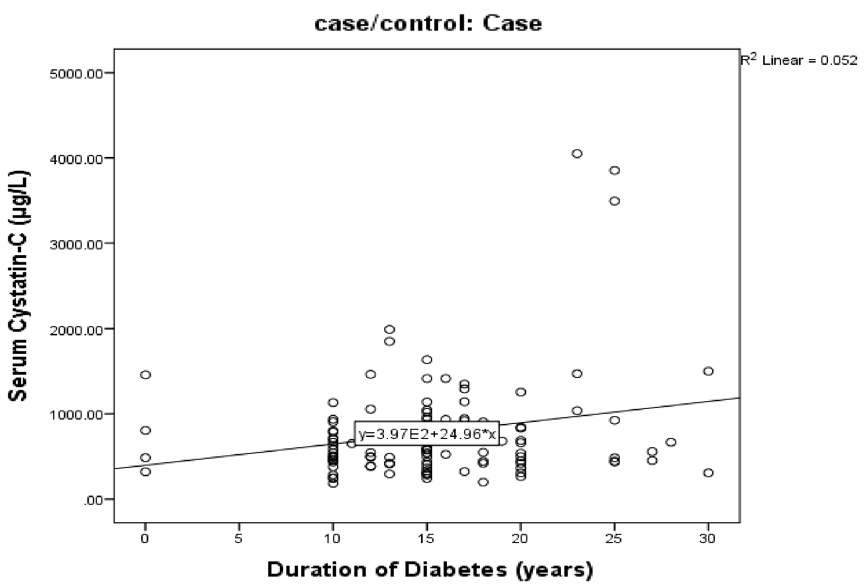
Figure 1. Correlation between duration of diabetes and level of serum cystatin-c in diabetic patient